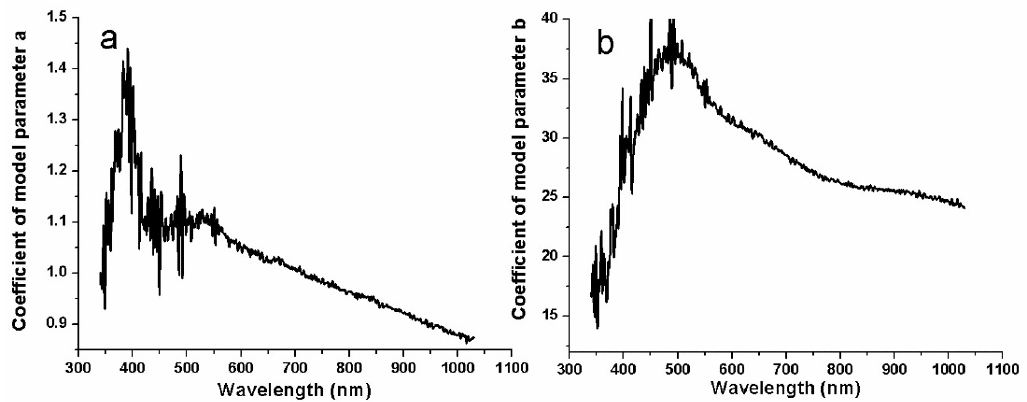
Figure 12. ( a ) Parameter a and ( b ) parameter b of the exponential relationship model over wavelength.